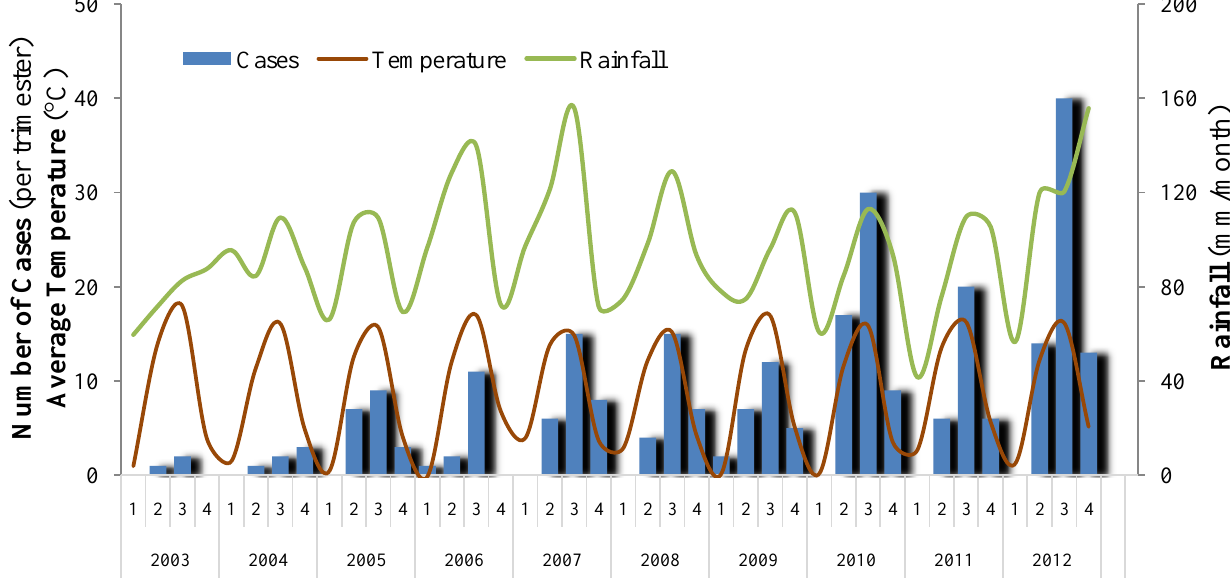
Figure 7. Distribution of 256 cases of leptospirosis by quarters for the 10 mainly affected cantons (2003–2012) and corresponding temperature and rainfall